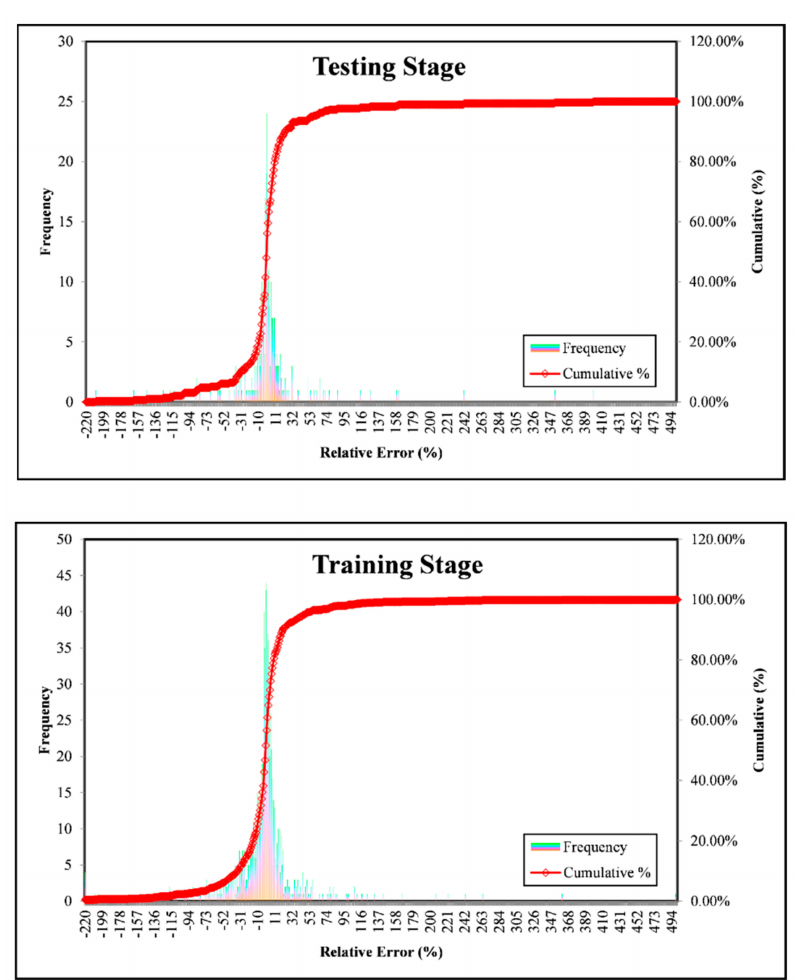
Figure 5. Relative deviation between actual and estimated solubility of hydrocarbons.